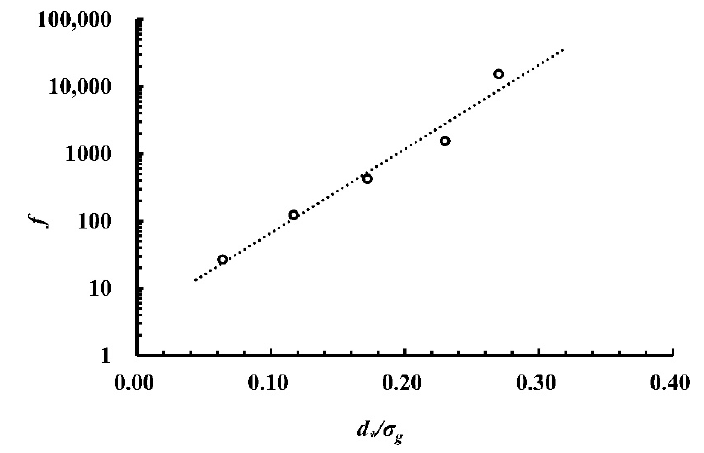
Figure 8. Distribution of 𝑚 as a function of 𝑑 ∗ 𝜎 (cid:3034) ⁄ . The value of m increases with 𝑑 ∗ 𝜎 (cid:3034) ⁄ .